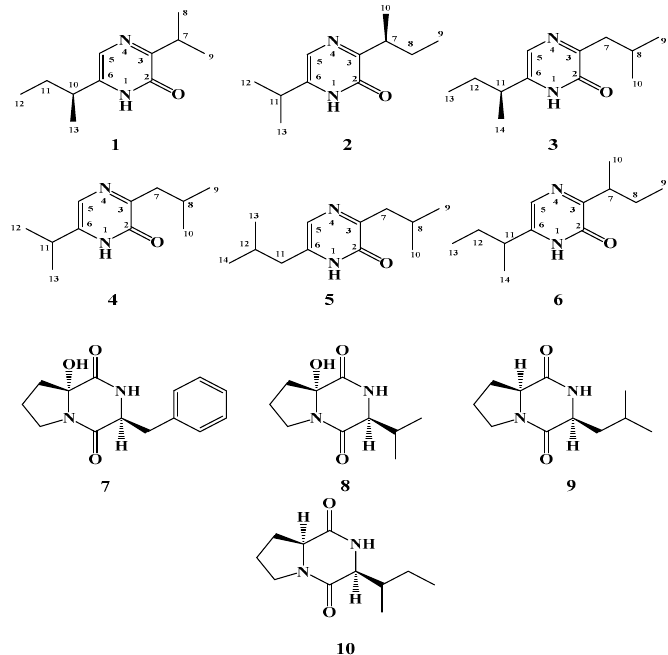
Figure 1. Structures of compounds 1 – 10 .